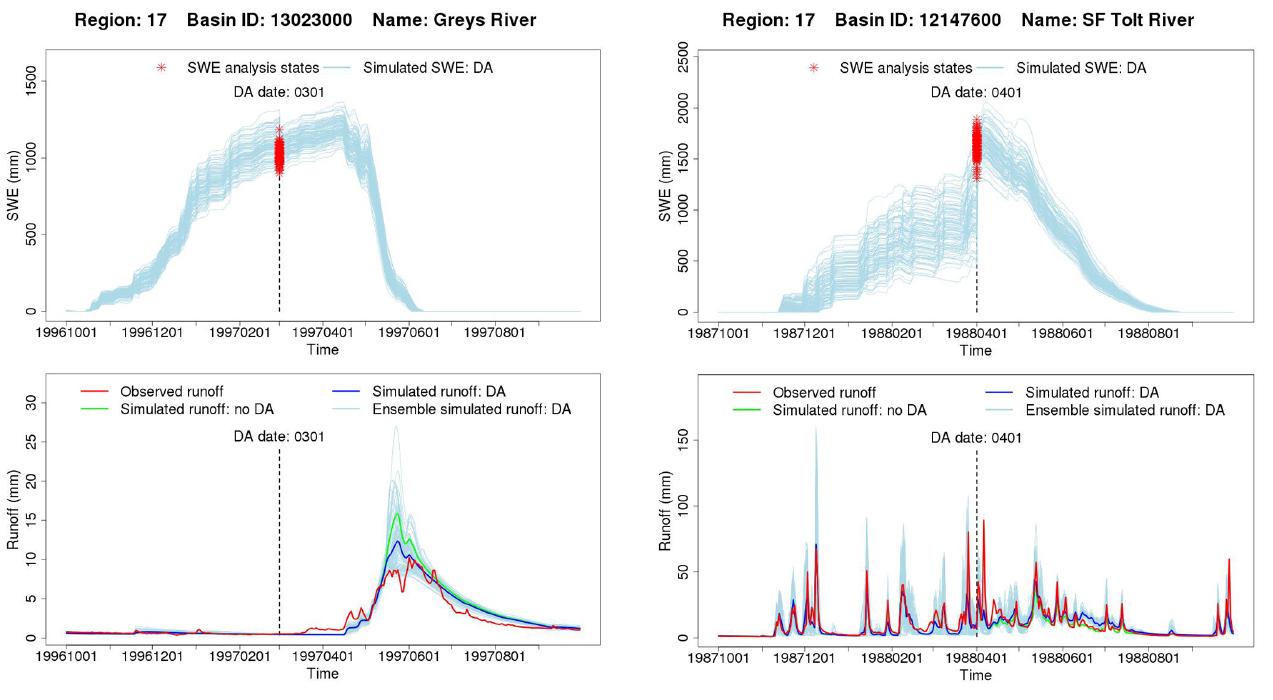
Figure 9. Time series plots for SWE and runoff for the south fork (SF) of the Tolt River for water year 1988. Light blue lines indi- cate individual ensemble member traces. Vertical black dashed line denotes the DA